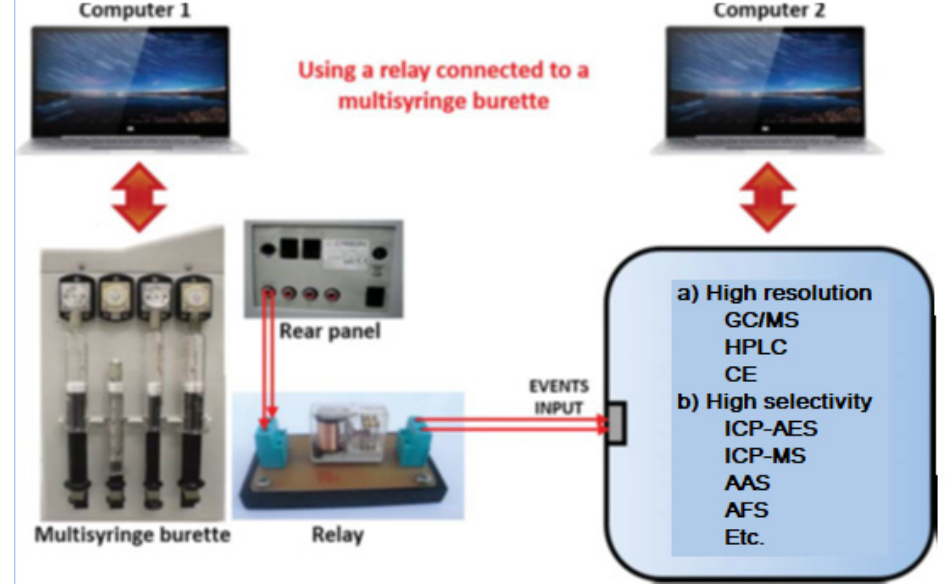
Figure 10. Coupling a multisyringe burette using a relay as an interface connected to the event input of another instrument.